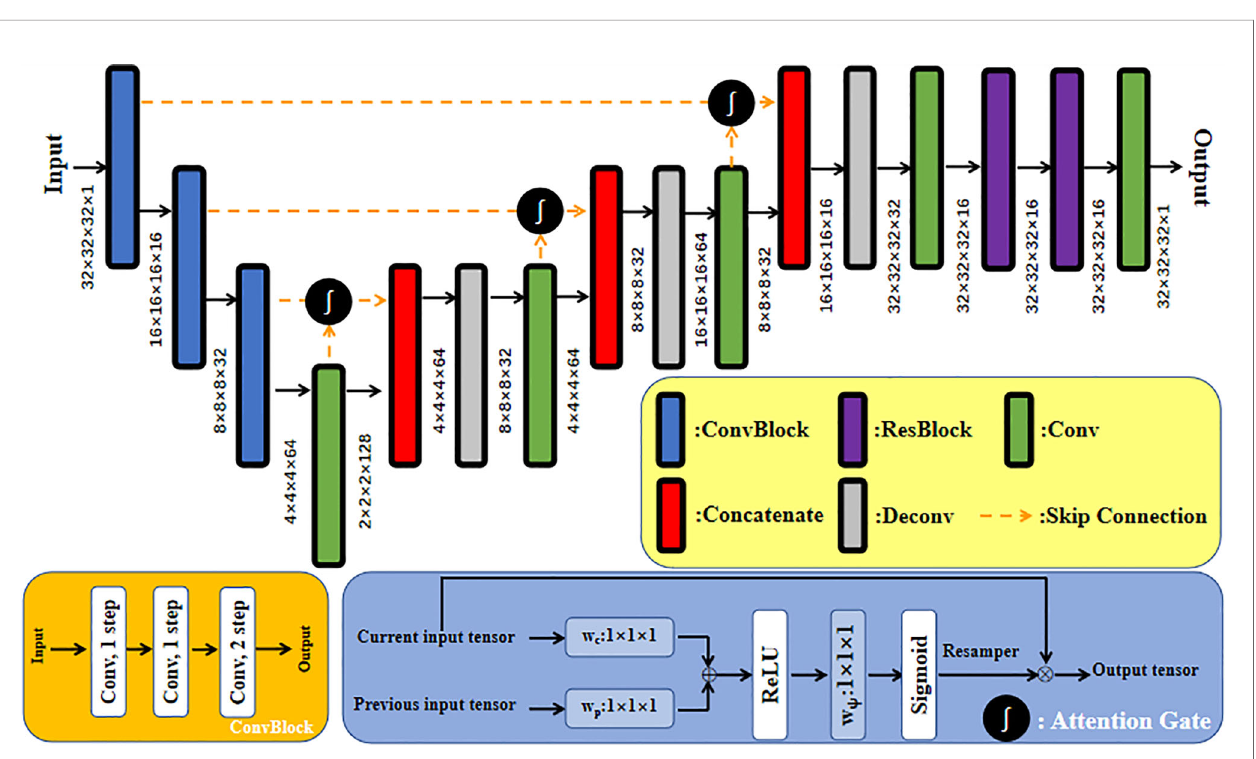
FIGURE 2 | U-Net network structure of generator with residual connection and attention